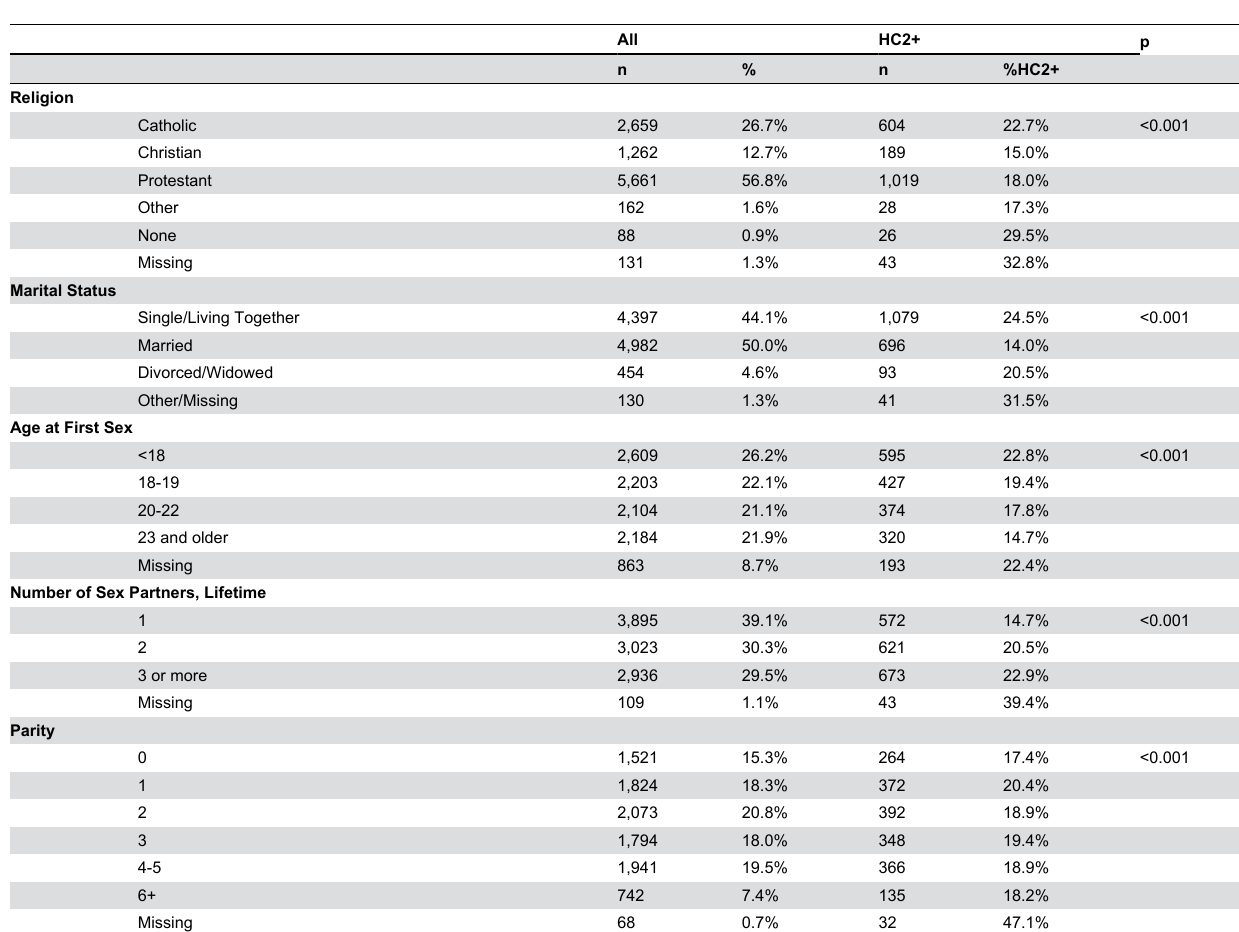
Table 1. Population Demographics.